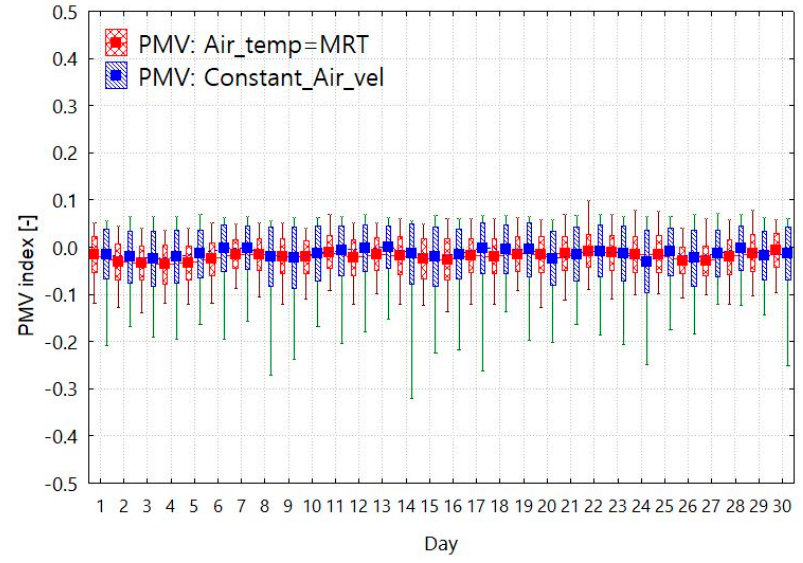
Figure 12. Daily PMV error in two scenarios with optimal setpoint of base case.